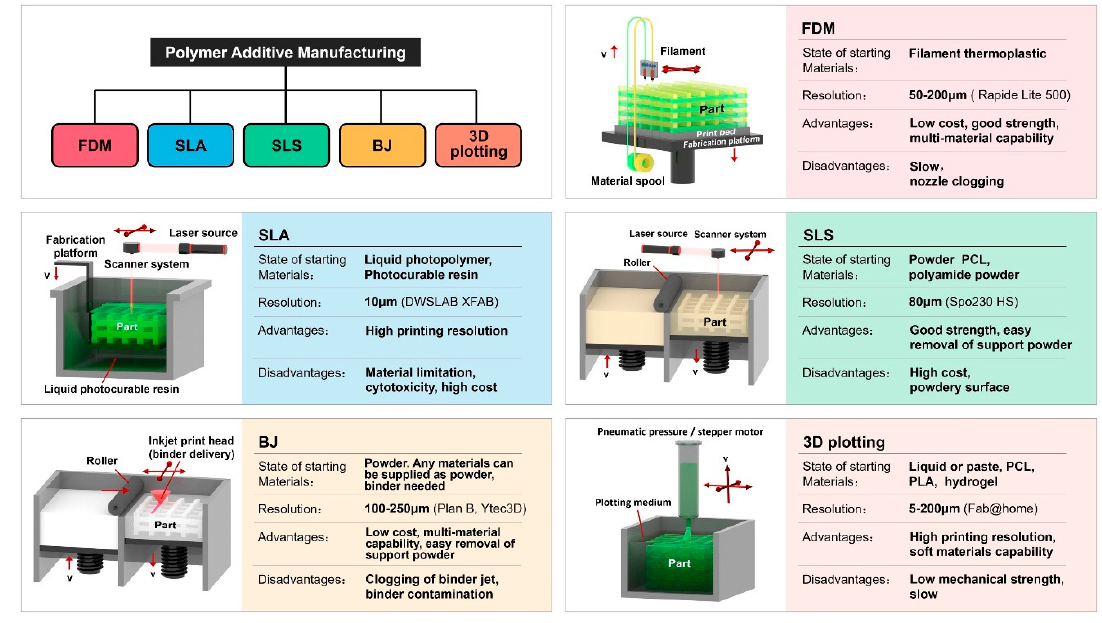
Figure 4. Various 3D printing technologies for polymer materials. Figure reproduced from